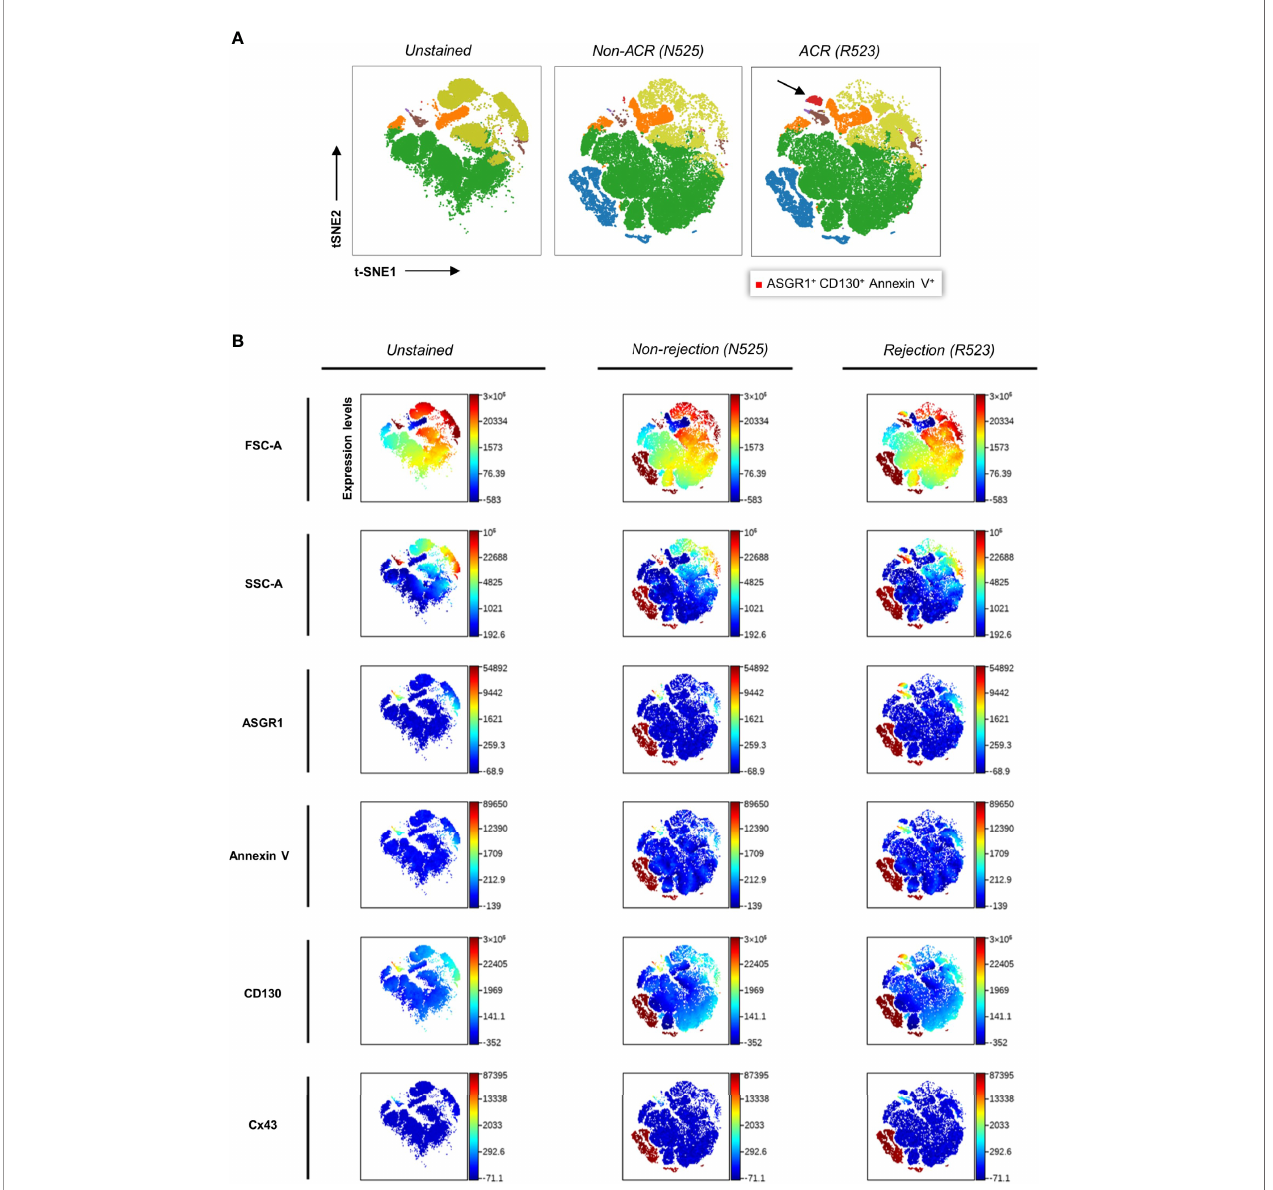
FIGURE 5 | Clustering and color coding with FlowSOM and viSNE for identifying EP subpopulations via density plots. (A) Qualitative analysis and population identi fi cation were performed using viSNE and FlowSOM on samples of patient 52, who had episodes of graft dysfunction caused by ACR and non-ACR. Several LBs were performed over time, and their concomitant blood samples presented the following data. t-SNE (t-distributed stochastic neighbor embedding), an unsupervised nonlinear dimensionality reduction algorithm, was used to fi t six-dimensional data into two dimensions. All clusters were created via FlowSOM analysis. Clusters were formed based on FACS channels. The arrow indicates the novel ASGR1 + CD130 + AnnV + EP population. Coordinates for each t-SNE dimension (t- SNE1 and t-SNE2) were calculated for each microparticle after dimensionality reduction. (B) Color-coded t-SNE density plots showing different antigen expression levels by the channel of above-mentioned